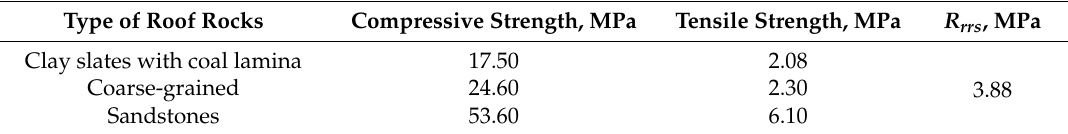
Table 3. Parameters characterizing rocks littering in the roof of the longwall and forming goaf with